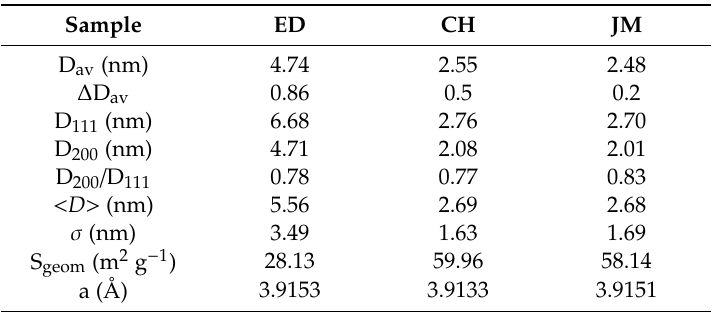
Table 2. XRD data of the Pt / C